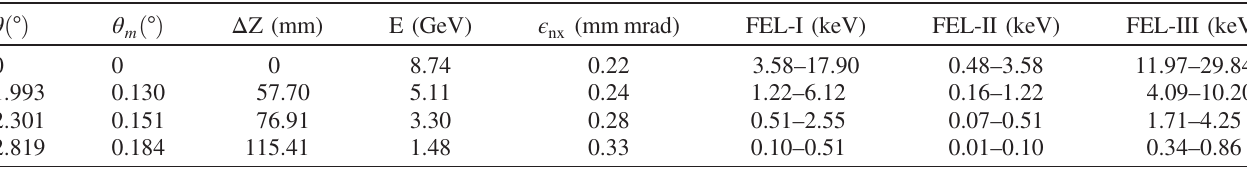
TABLE I. Parameters of the four typical electron beams and the corresponding spectrum